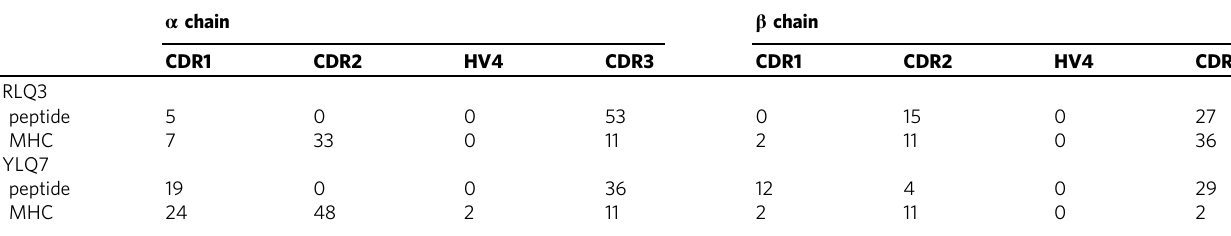
Contacts were calculated between non-hydrogen atoms with a 4.0Å distance cutoff.